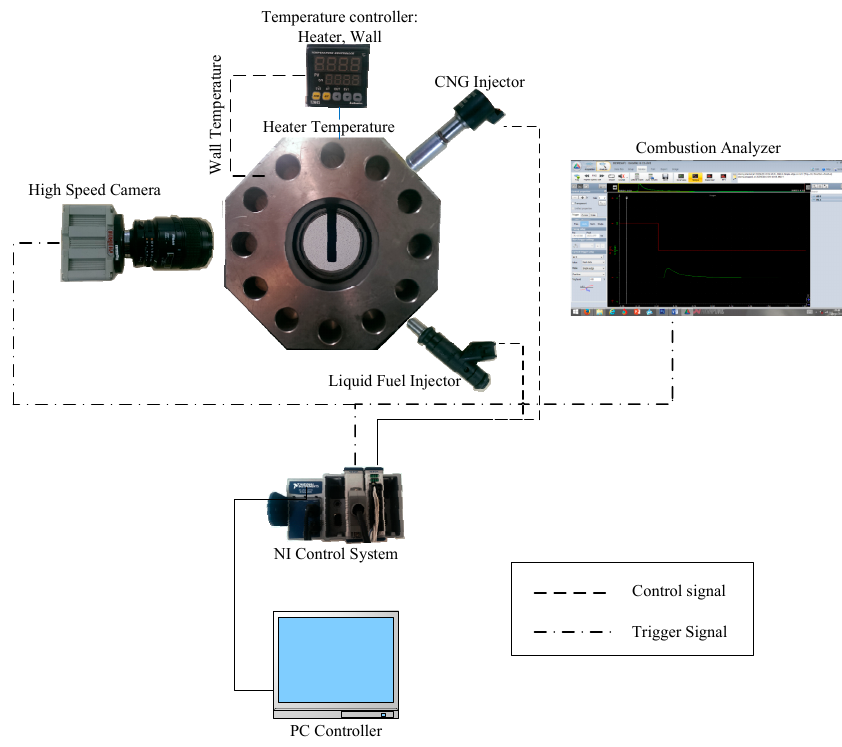
Figure 1. Fuel injector, heater arrangement and experimental schematic in the Constant volume chamber (CVC).